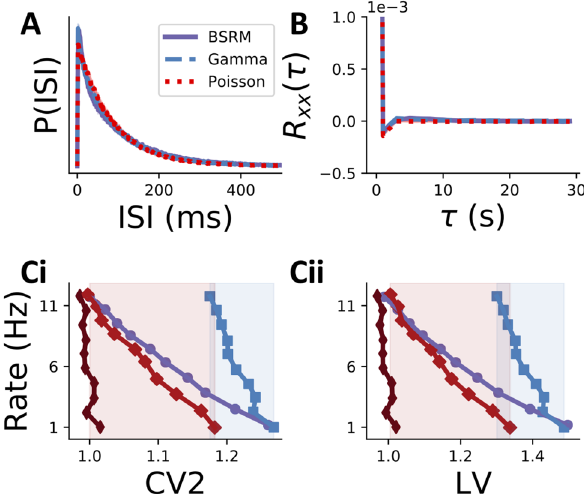
Figure 6. Common metrics of spike train irregularity do not distinguish functionally bursty cells. ( A ) ISI distribution of the BSRM model in effective multiplexing regime (solid, purple) is almost identical to that of a homogeneous, refractory, gamma renewal process (dashed, blue), and highly similar to that of a Poisson process (dashed, red). ( B ) Autocorrelation of spike trains from ( A ) are almost identical. Y-axis units are [spikes] 2 . ( C ) Plotted are values of a given spike train statistic (x-axis) for a range of neuron spike rates (y-axis) for three different models: a single-input rate model with high input signal variance (light red, wide diamonds), the same rate model with low input variance (dark red, thin diamonds), a stationary gamma renewal process with shape parameter 0.5 (blue, squares), and the BSRM with 6 ms refractory period (purple, circles). LV ( i ) and CV2 ( ii ) values of the BSRM overlap substantially with the high-variance input rate coding model (red shaded region) and stationary gamma renewal process (blue shaded region). Each line in ( A ) and ( B ) denotes the mean ISI distribution (autocorrelation) over ten trials, where each trial value was calculated from a 5000 second long spike train. Shaded regions give ± 1 standard deviation (over trials) and are negligibly thin. All data points in ( C ) were calculated from simulations of 4800 second long spike